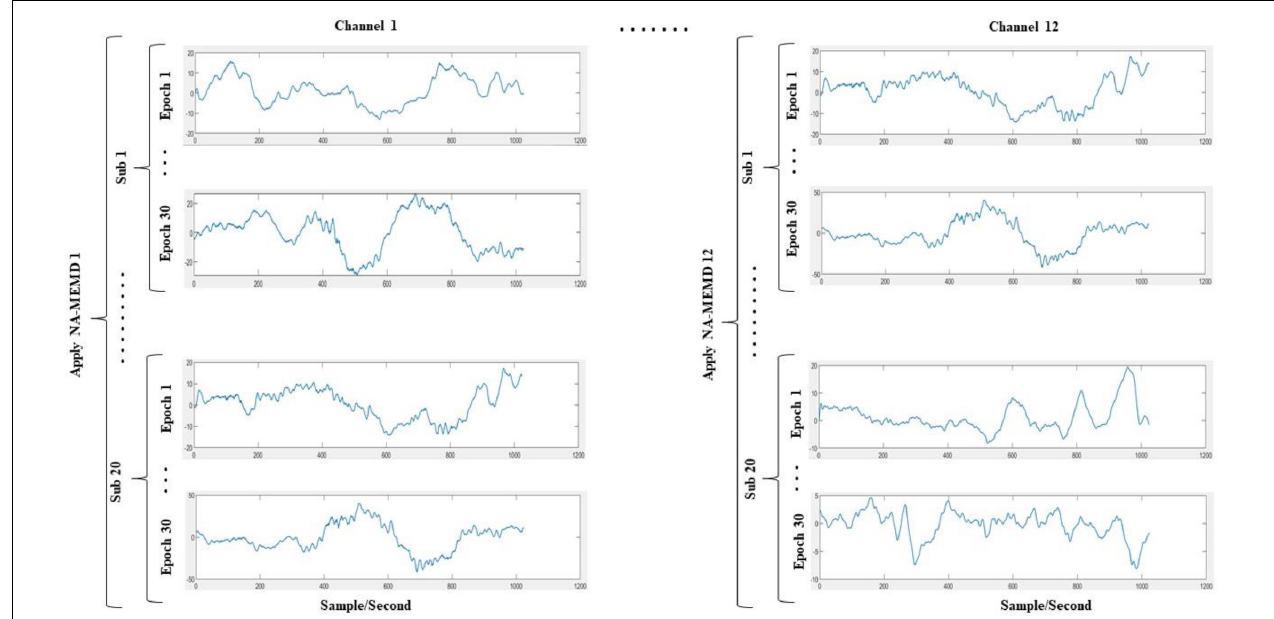
FIGURE 3 | Proposed simultaneous decomposition method of the EEG signals. The data points of all infants (including all epochs) are stacked on top of each other. This process is done for each channel separately, ending up with 12 multivariate signals; each of them has the dimensionality of [ N s × N e ] × N t , where N s denotes the number of infants (which is 20), N e is the number of epochs of each infant (which is 30), and N t indicates the number of temporal samples (which is 1024). The NA-MEMD is then applied for each of the 12 multivariate signals separately.